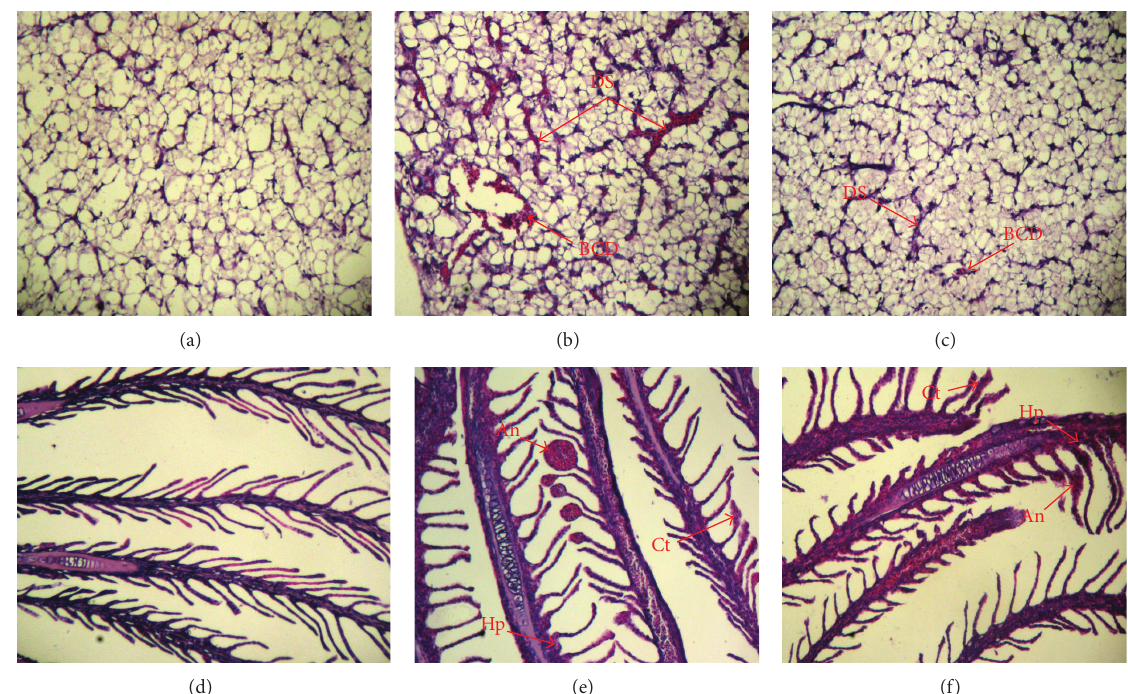
Figure 2: Effects of Cu-NPs and CuSO 4 on liver and gills morphology of juvenile Epinephelus coioides after 25-day exposure. (a) Liver from control, (b) liver from 100 𝜇 gCuL −1 as CuSO 4 , (c) liver from 100 𝜇 gCuL −1 as Cu-NPs, (d) gills from control, (e) gills from 100 𝜇 gCuL −1 as CuSO 4 , and (f) gills from 100 𝜇 gCuL −1 as Cu-NPs. In liver, all treatments showed injuries that include blood cell deposition in veins (BCD) and dilatation of sinusoids (DS). In gills, all treatments showed injuries that include hyperplasia (Hp), aneurism (An), and clubbed tips (Ct). Sections were 7- 𝜇 m thick and stained with haematoxylin and eosin (H&E, × 100).